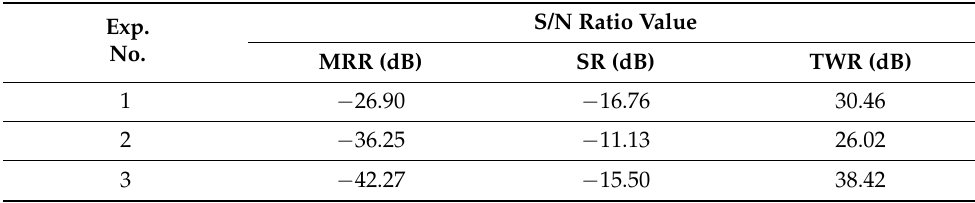
Table 7. S/N ratio for various